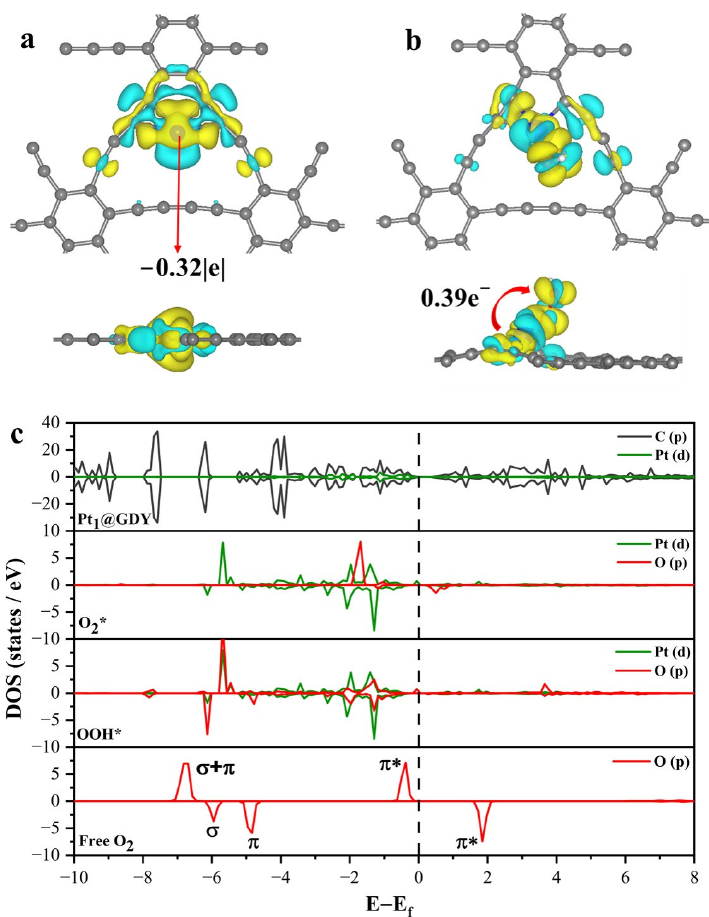
Figure 5. Top and side views of charge differential density (CDD) plots of ( a ) Pt 1 @GDY and ( b ) OOH* on Pt 1 @GDY. The blue and yellow areas represent positive and negative charge accumulation, respectively. The isosurface value is set to 0.002 e/Bohr 3 . ( c ) Partial density of states (PDOSs) of the free O 2 and O 2 */OOH* on Pt 1 @GDY. The Fermi level is set to